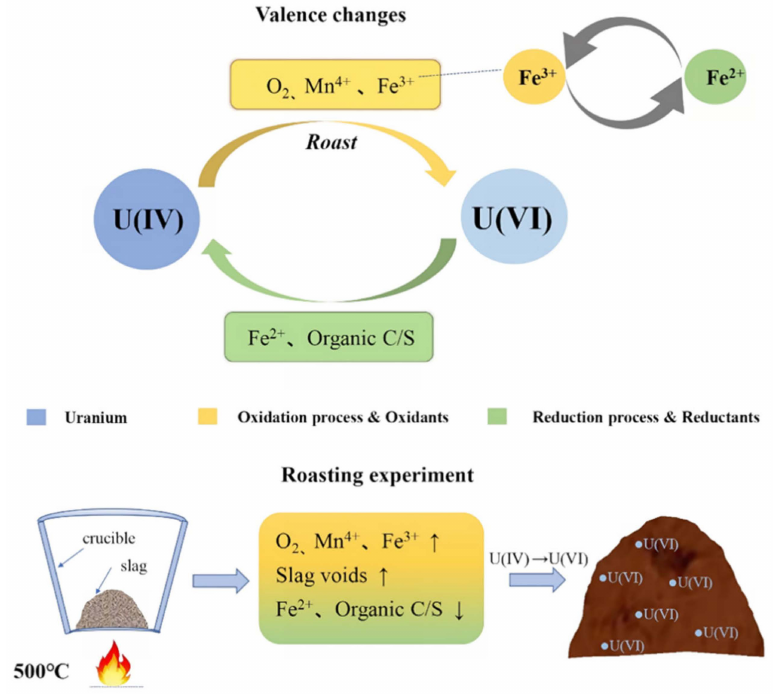
Figure 10. Morphological mechanism analysis of